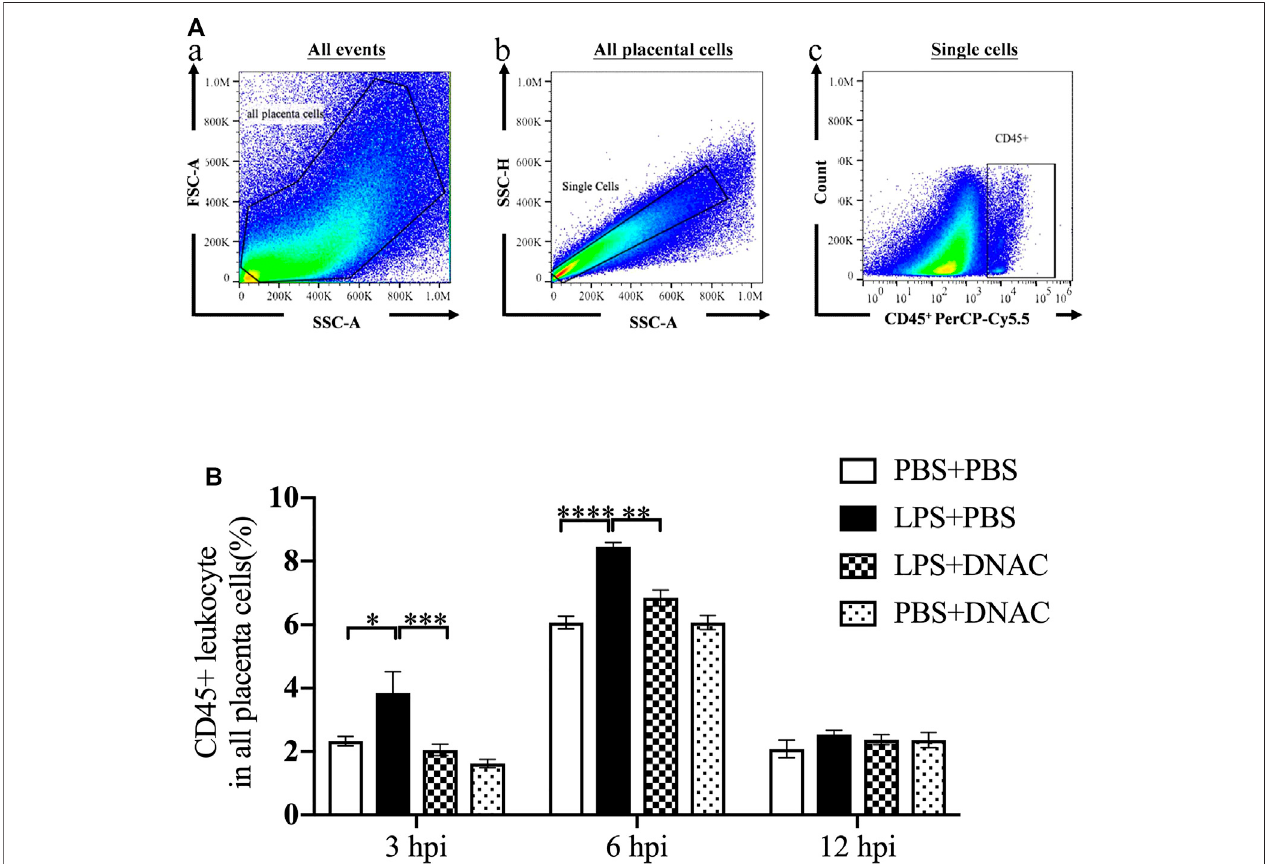
FIGURE 2 | Placenta leukocytes in fi ltration following exposure to intrauterine in fl ammation and maternal Dendrimer-based N-Acetyl Cysteine (DNAC) treatment. Lipopolysaccharide (LPS) or phosphate-buffered saline (PBS) was injected intrauterine at embryonic day 17 (E17). DNAC was injected intraperitoneally 1 h post in fl ammation (hpi). Placentas were collected at 3, 6 and 12 hpi. (A) a. All captured placental cells were distinguished based on properties of side scatter area (SSC-A) versus forward scatter area (FSC-A) generally, by using polygon/rectangular/oval gates. b. Debris and doublets were excluded by gating on side scatter height (SSC-H) versus SSC-A to further delaminate singlets. c. Placental leukocytes were gated sequentially on CD45 + versus SSC-A properties. (B) The ratio of CD45 + leukocytesin fi ltratedintheplacentawerestatically compared betweengroups.PBS+PBS, n (cid:1) 16;LPS+PBS, n (cid:1) 16;LPS+DNAC, n (cid:1) 15;PBS+DNAC, n (cid:1) 12.* p